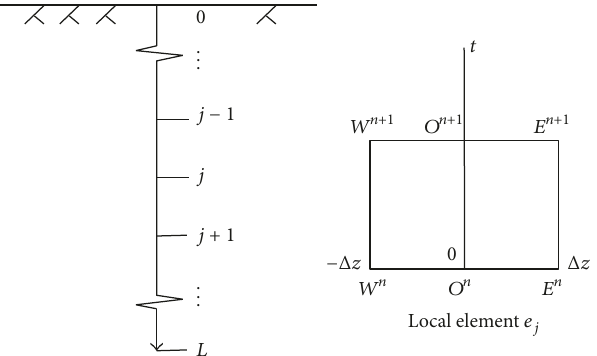
Figure 1: Domain and local element of finite analytical